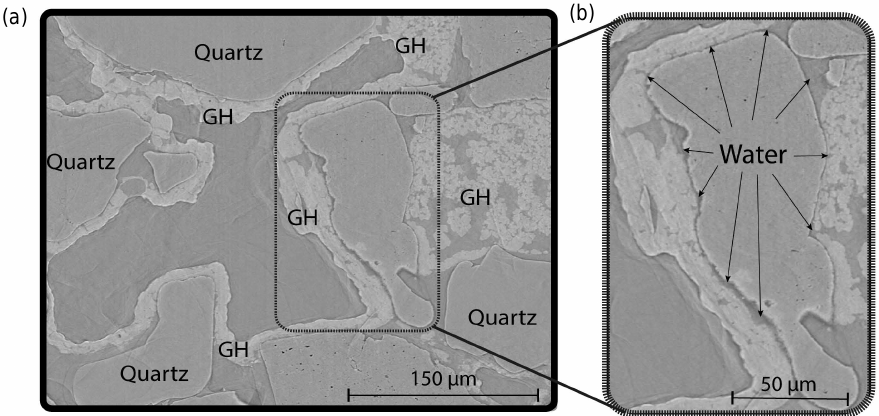
Figure 2. (a) Overview of an unfiltered 2-D slice in y , z direction of quartz sand containing GH. Note that due to its unfiltered state this image contains artifacts, such as streaks and slight edge enhancement. Phases can be identified based on grey scale differences.